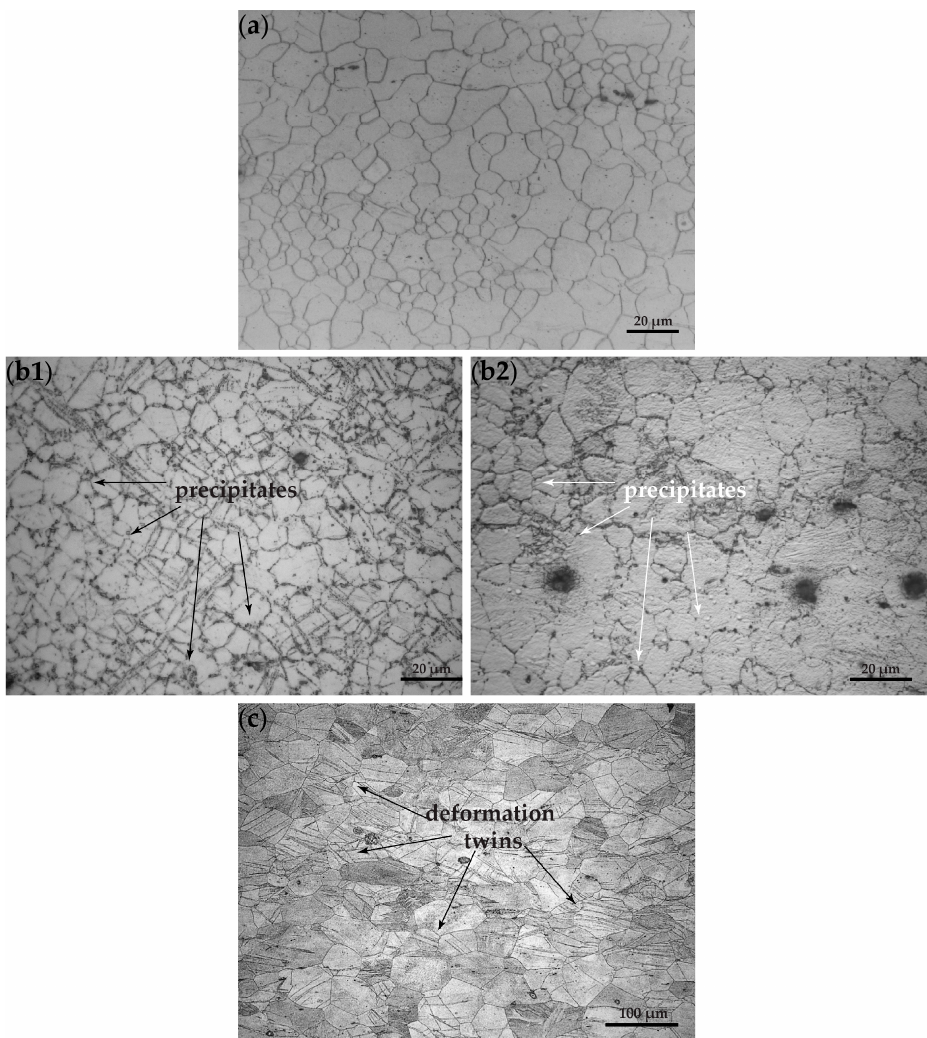
Figure 2. Optical microscopy micrographs depicting the microstructure of magnesium alloys in the (LS) plane: ( a ) AZ31; ( b1 ) AZ61 top area; ( b2 ) AZ61 middle area; and ( c ) WE43-T5.